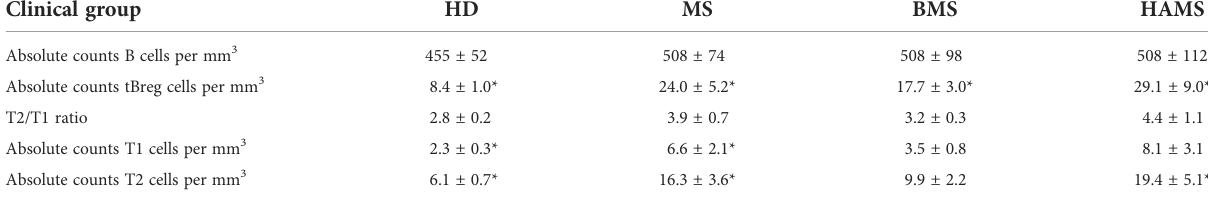
TABLE 2 Total numbers and frequency of T1/T2 subpopulations of transitional B cells in peripheral blood from the MS patients and healthy donors. Clinical group